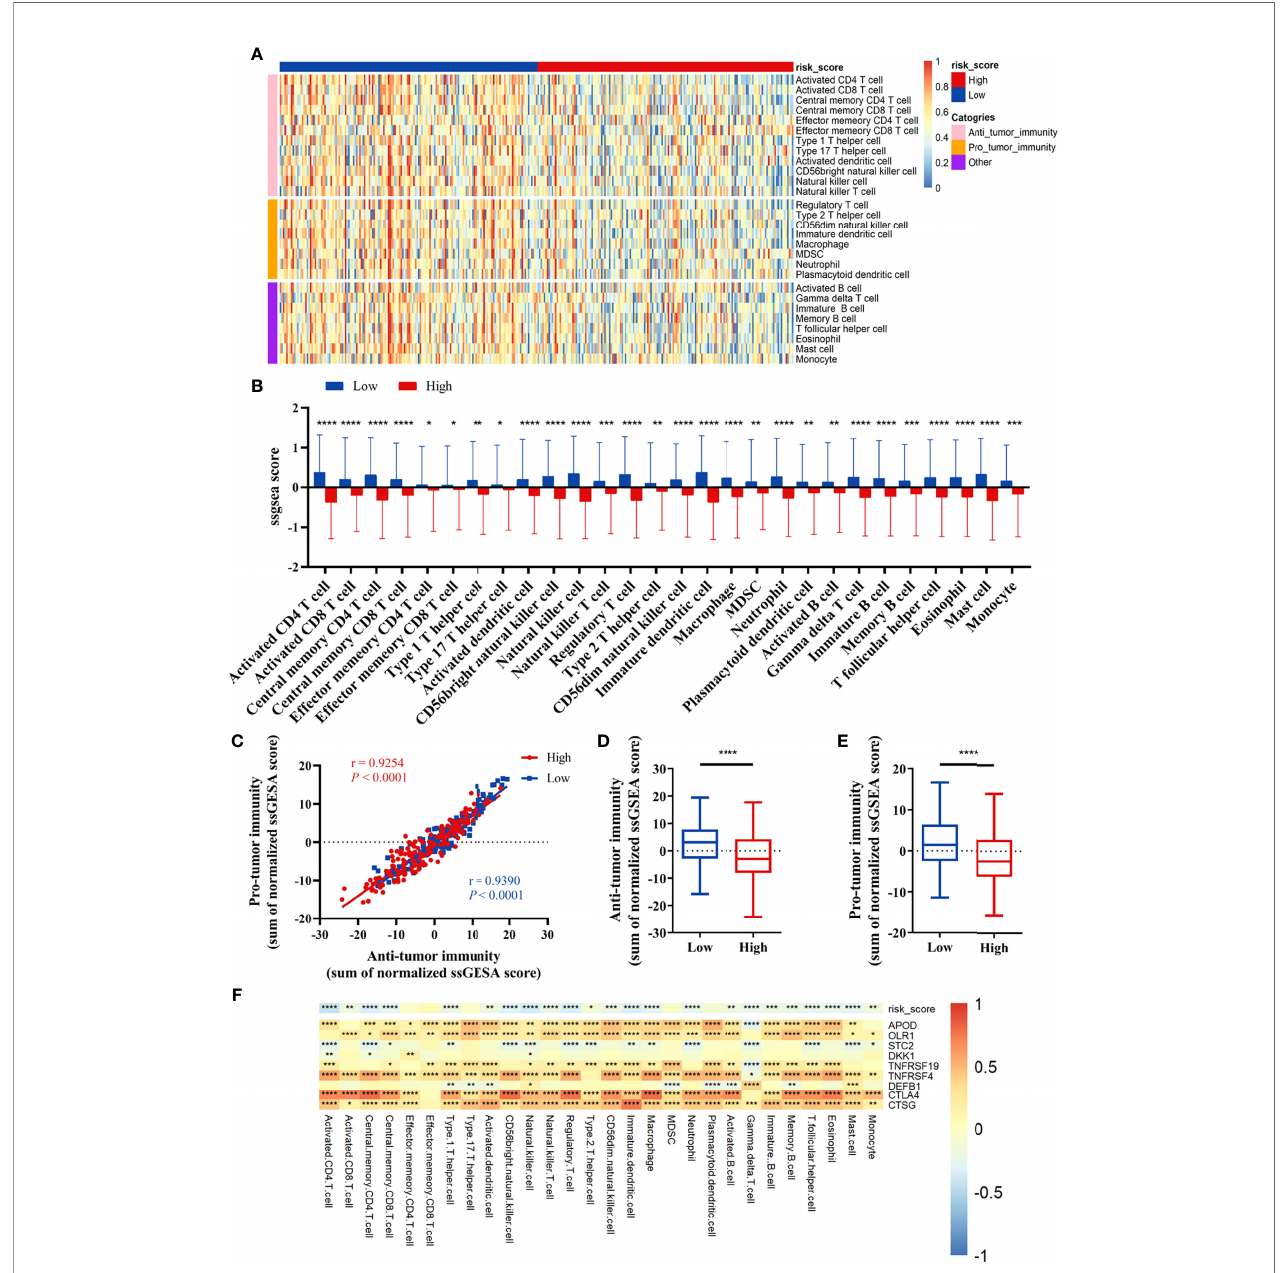
FIGURE 6 | Correlation between immune cell in fi ltration and the prognostic signature in the TCGA cohort. (A, B) The in fi ltration ratio of 28 immune cells. (C) Correlation of the cells with anti-tumor immunity and pro-tumor immunity. (D, E) Anti-tumor immunity and pro-tumor immunity scores of the risk score model. (F) The correlation between the immune-related signature and the ssGSEA scores of 28 immune cells. All p -values for signi fi cance (<0.05) represent comparisons via two-tailed t -test and multiple t -tests with FDR < 0.05. * p -value<0.05, ** p -value<0.01, *** p -value<0.001, and **** p